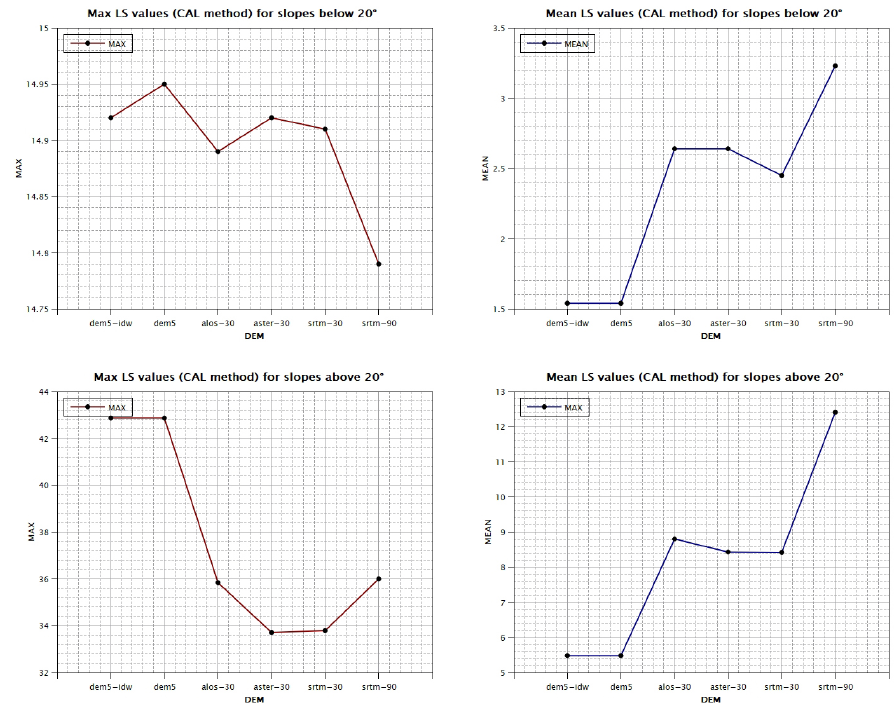
Figure 11. Maximum and mean values of LS factor for slopes below and above 20° (CAL method).